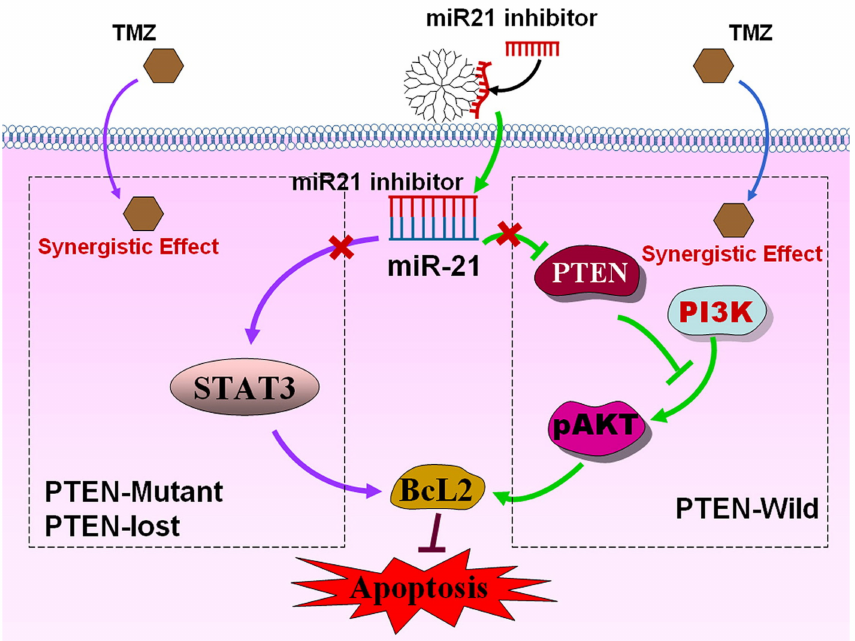
Figure 3. Mechanism of combination therapy for miR-21i and TMZ. miR-21i was delivered by PAMAM into the cells and coordinated with miR-21, leading to inactivation of miR-21. For LN229 cells (PTEN-wild), the inactivation of miR-21, which is inhibited by the simultaneous miR-21i and TMZ treatment, targets and reduces the expression of PTEN, blocks the PI3K-pAKT pathway, induces an increase in apoptosis, and leads to synergistic antiproliferative activity. For U251 (PTEN mutant) and U87 (PTEN-lost) cell lines with high STAT3 expression, the synergistic effect was achieved by sequence treatment of the two drugs. Reprinted with permission from [78], copyright (2021) American Chemical